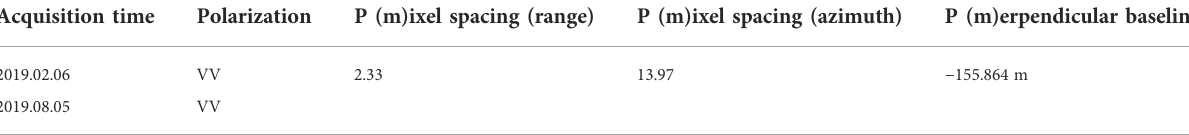
TABLE 3 Select the main information and basic parameters of the